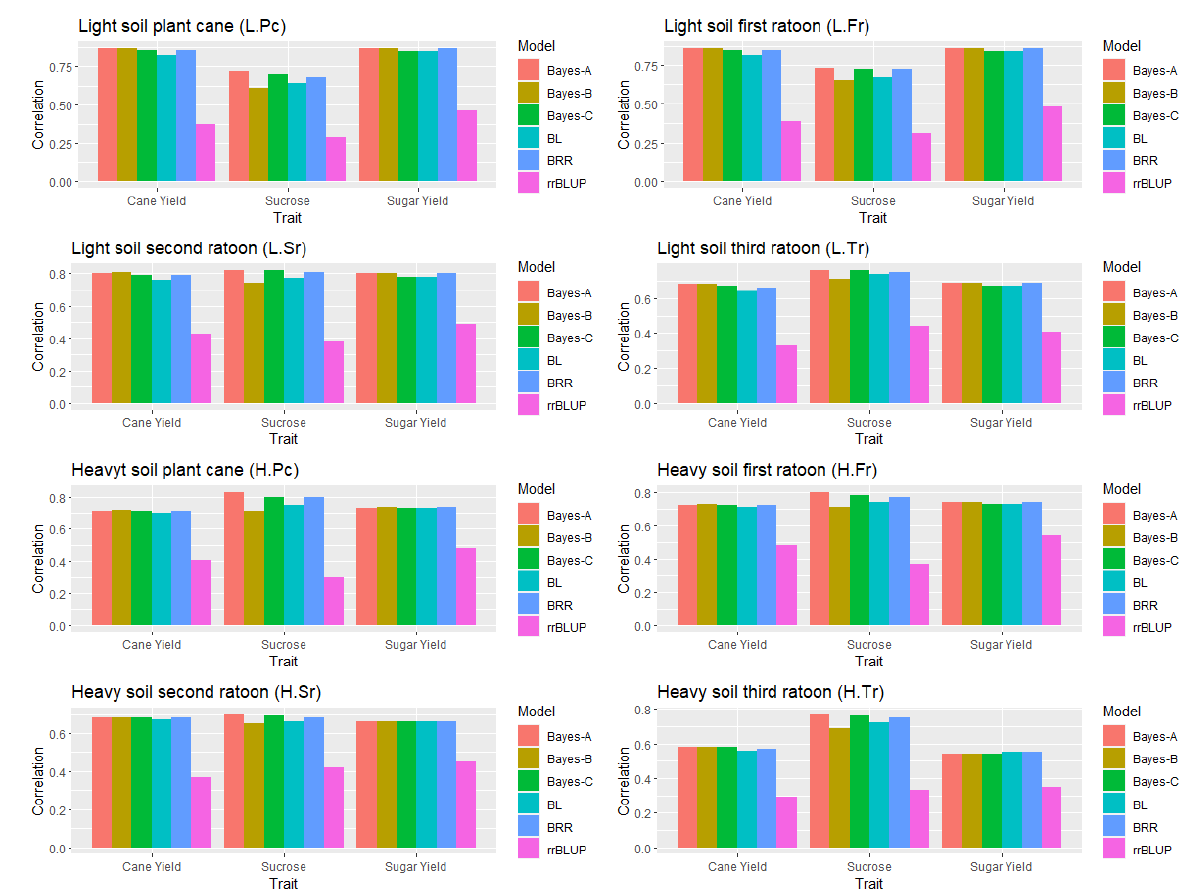
Figure 1. Rank correlation between the actual (BLUEs) and predicted phenotypic values (GEBVs) by taking all combined dataset as the training data (no fixed effect). Light soil (averaged over crop type); plant cane (averaged over soil type); ratoon cane (averaged over soil type). L — light soil, H — heavy soil, Pc — plant cane, R — ratoon, and Fr — first ratoon.